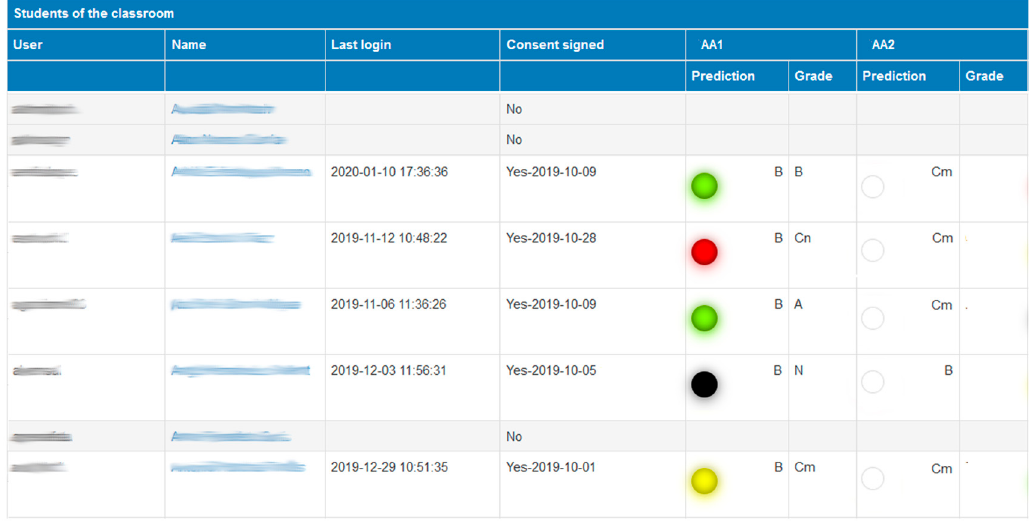
Figure 6. Tabular dashboard for teachers to check the predictions for the students.